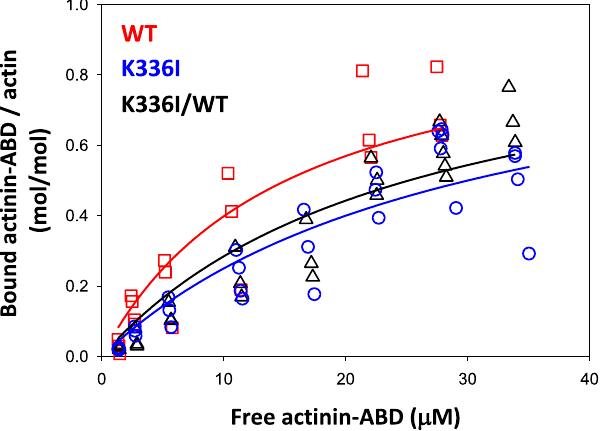
Figure 2. Co-sedimentation of K336I actin filaments and alpha-actinin ABD. Solid lines show data fit using the following equation: [alpha-actinin ABD] bound /[F-actin] = [alpha-actinin ABD] free /K d + [alpha-actinin ABD] free . The dissociation constants (K d ) of alpha-actinin ABD from actin filaments were as follows: K336I homo-filaments ( blue circles ), 30.0 ± 2.7 µ M; WT homo-filaments ( red squares ), 15.1 ± 2.0 µ M; and K336I/WT co-filaments ( black triangles ), 25.2 ± 2.2 µ M (mean ± SE, N = 4). There is a statistically significant difference between WT homo-filaments and K336I homo-filaments ( t -test, p < 0.001) as well as between WT homo- filaments and K336I/WT co-filaments ( t -test, p < 0.01).